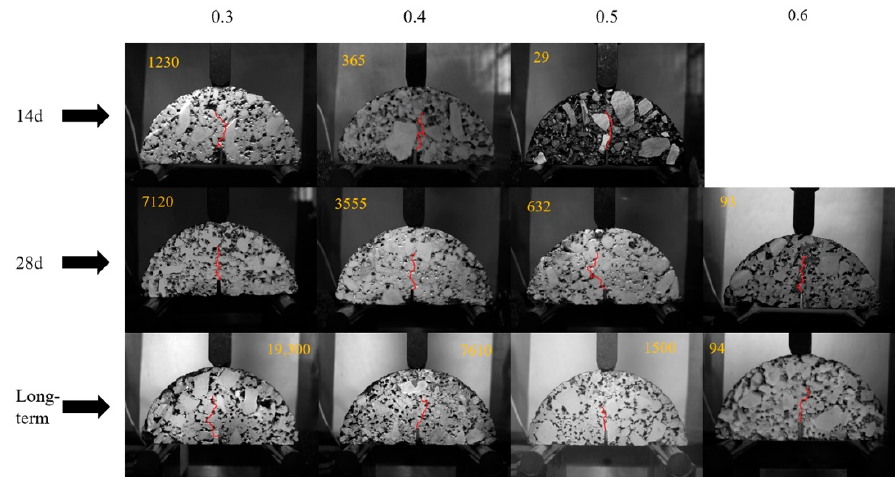
Figure 9. The fatigue failure point of the samples with different stress ration.